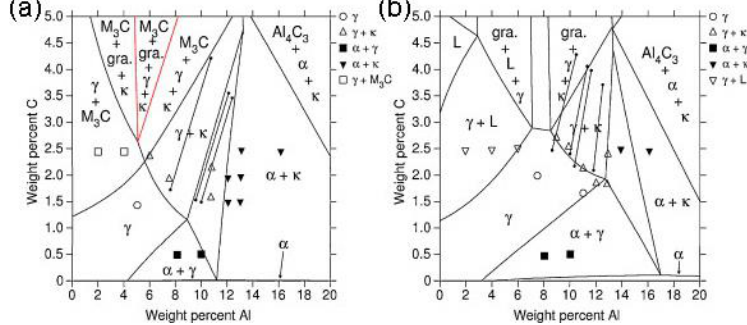
Figure 2. Calculated phase relations of Fe-20Mn-Al-C alloys at 900 °C ( a ) and 1200 °C ( b ), in comparison with experimental results. (Reprinted with permission from [13] Elsevier, 2010).